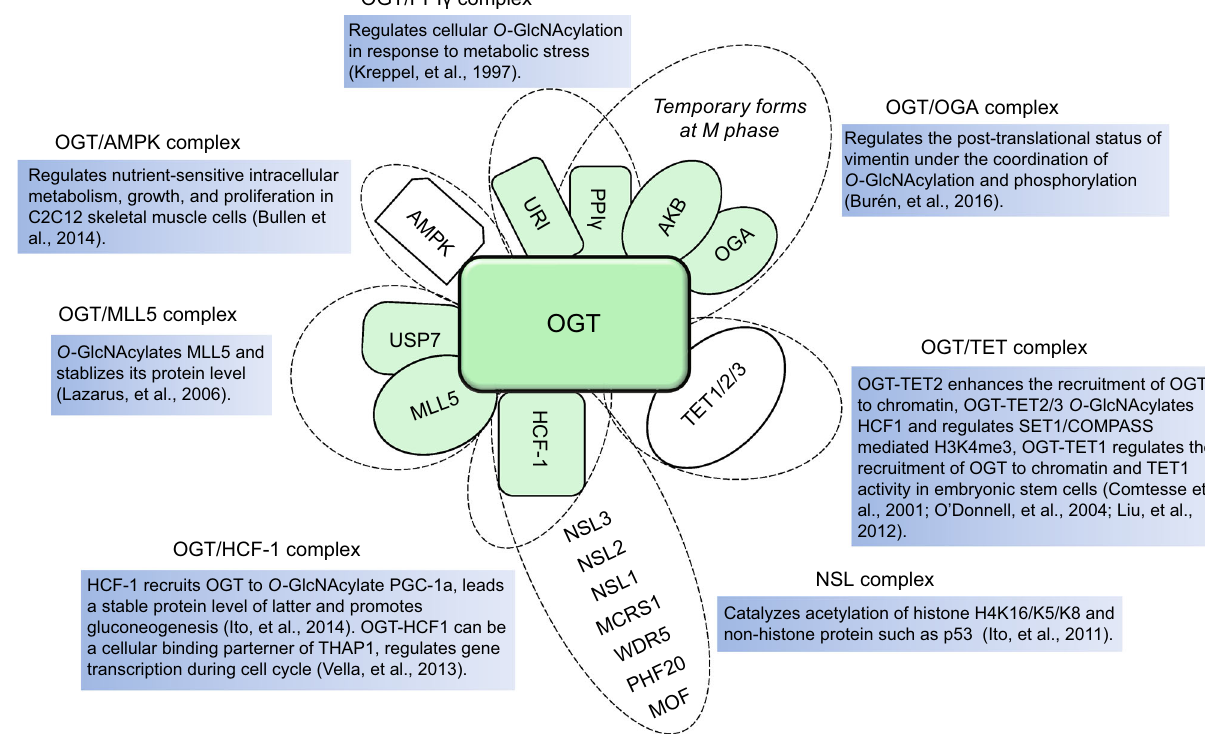
Figure 2. Regulation and function of OGT-mediated protein